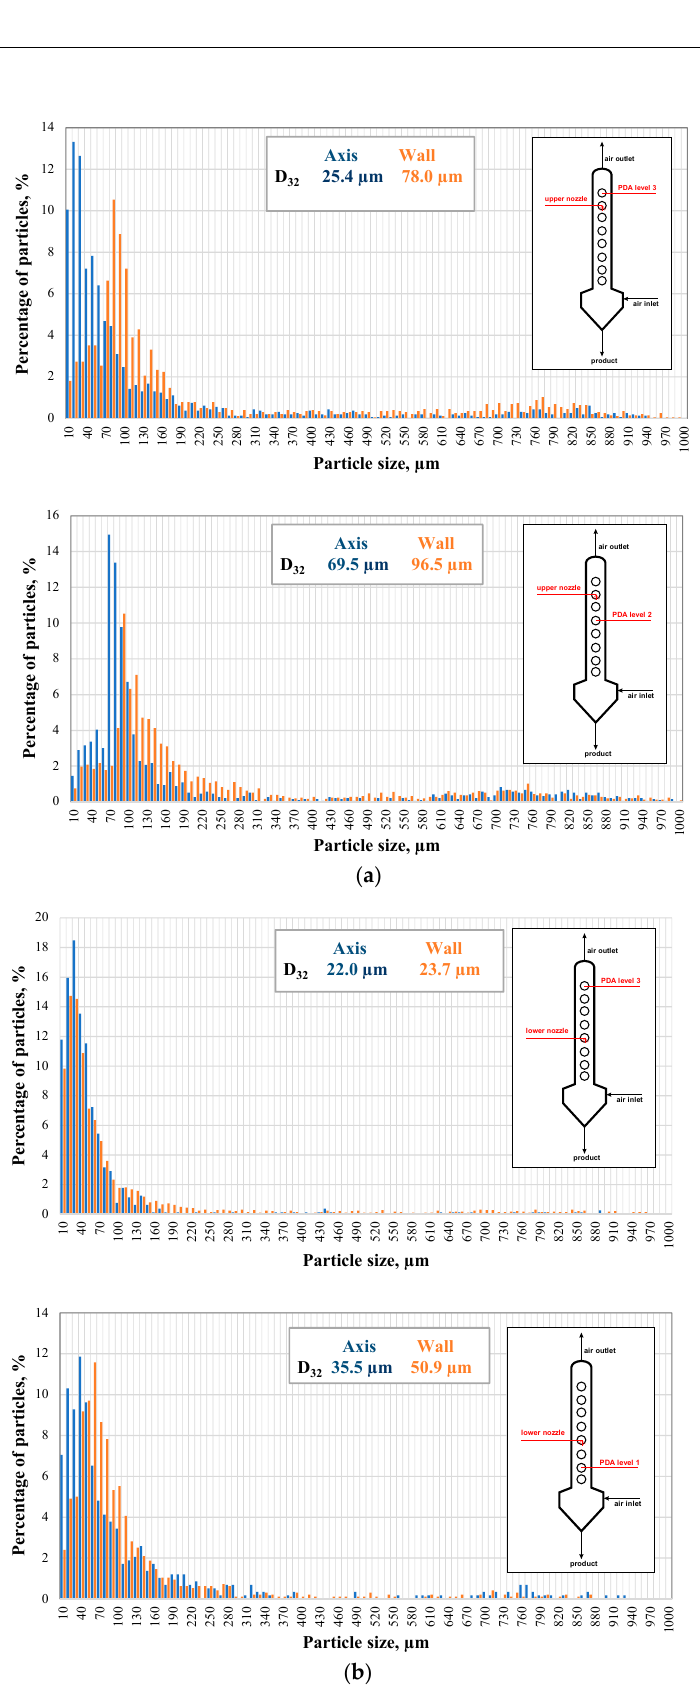
Figure 6. (( a ) Nozzle at the top ( b ) Nozzle at the bottom) PSD at the axis and at the wall above and below the nozzle (adapted from Ref. [33]).